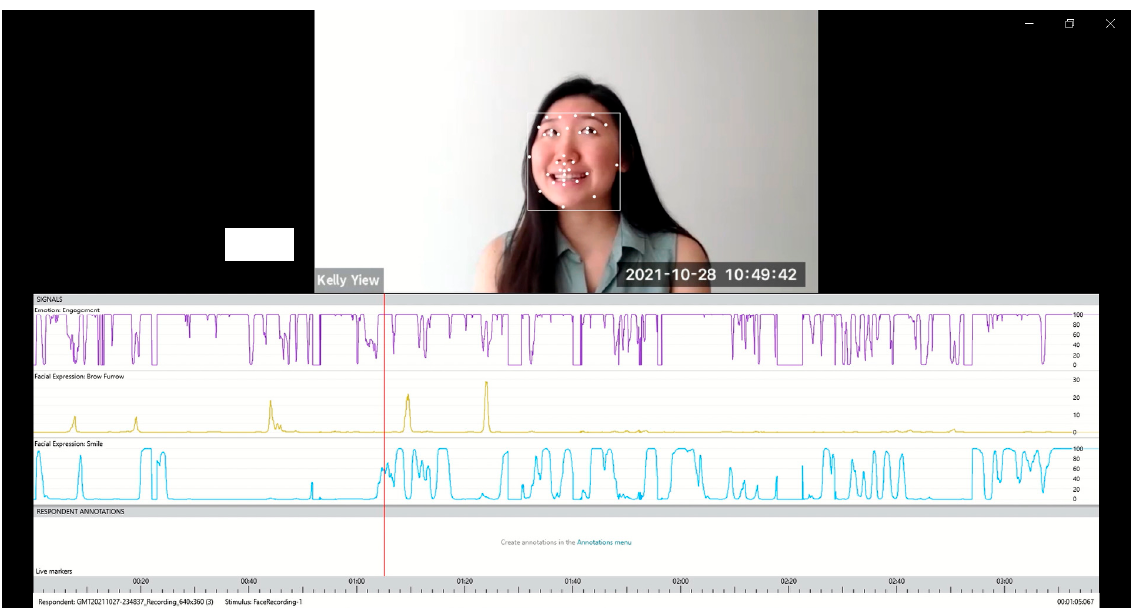
Figure 2. Screenshot demonstrating Affectiva functions.